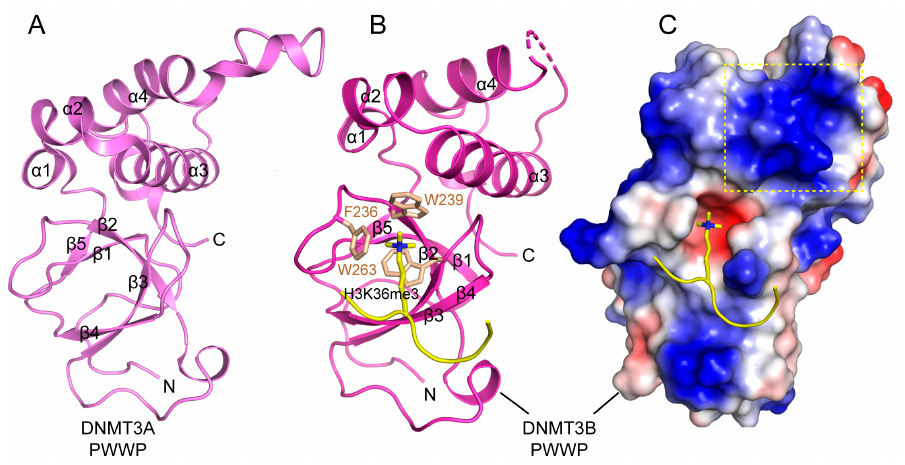
Figure 8. Structures of DNMT3A/3B Pro-Trp-Trp-Pro (PWWP) domains. ( A ) Crystal structure of the DNMT3A PWWP domain (PDB 3LLR). ( B ) Crystal structure of DNMT3B PWWP bound to the histone H3K36me3 peptide (PDB 5CIU), with the side chains of H3K36me3 and the cage residues of the